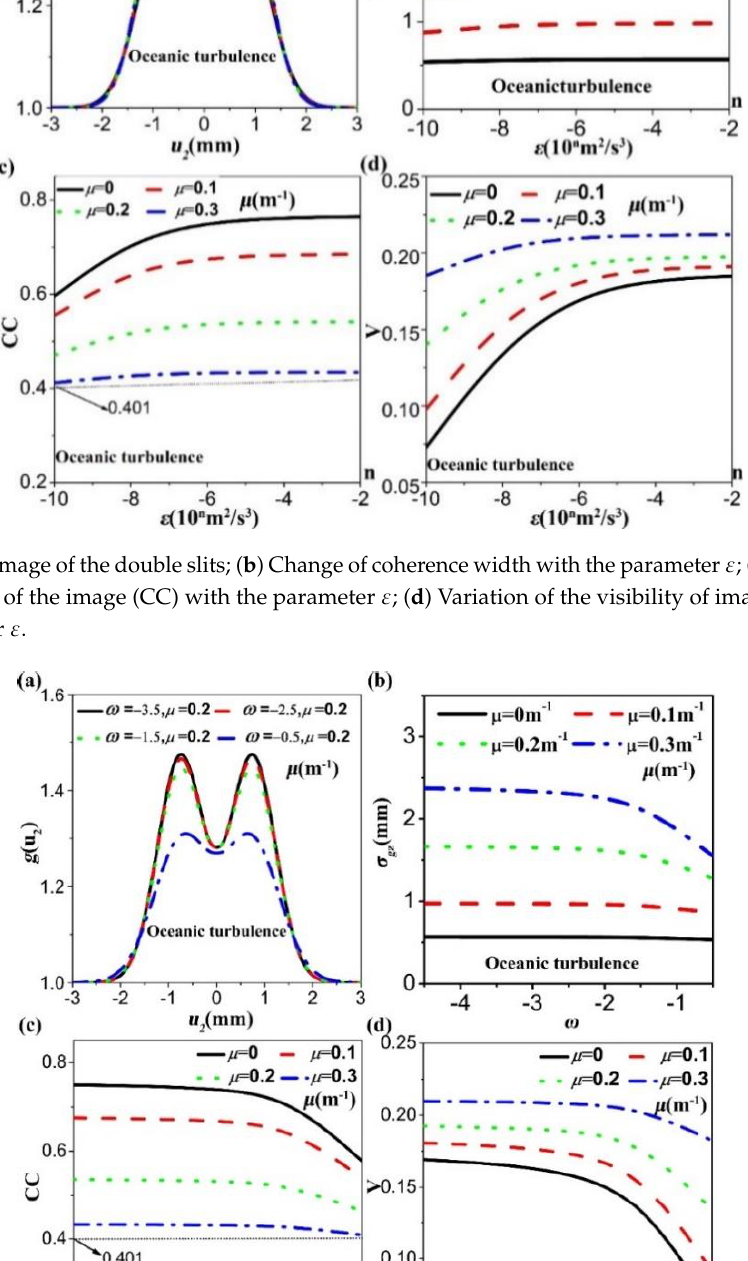
Figure 6. ( a ) Image of the double slits; ( b ) Changes of coherence width with parameter ω ; ( c ) Variation of the quality of the image (CC) with the parameter ω ; ( d ) Variation of the visibility of image ( V ) with the parameter ω.